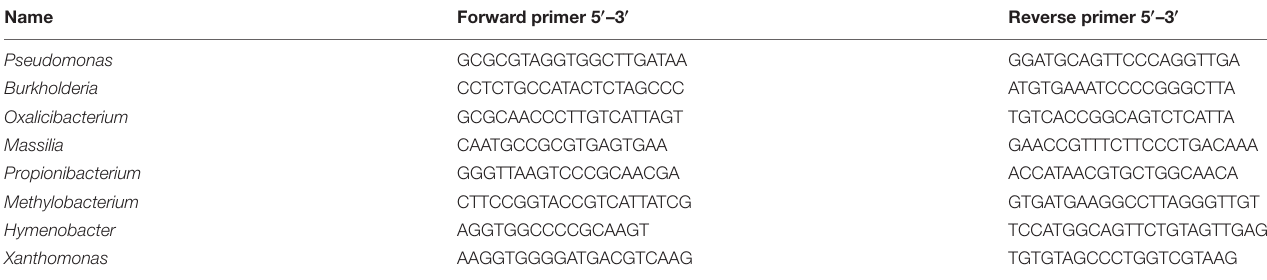
TABLE 1 | List of forward and reverse primer sets used for quantification of bacterial genera by Real-Time PCR on leonardite-treated and untreated samples. Name Forward primer 5 (cid:48) –3 (cid:48) Reverse primer 5 (cid:48) –3